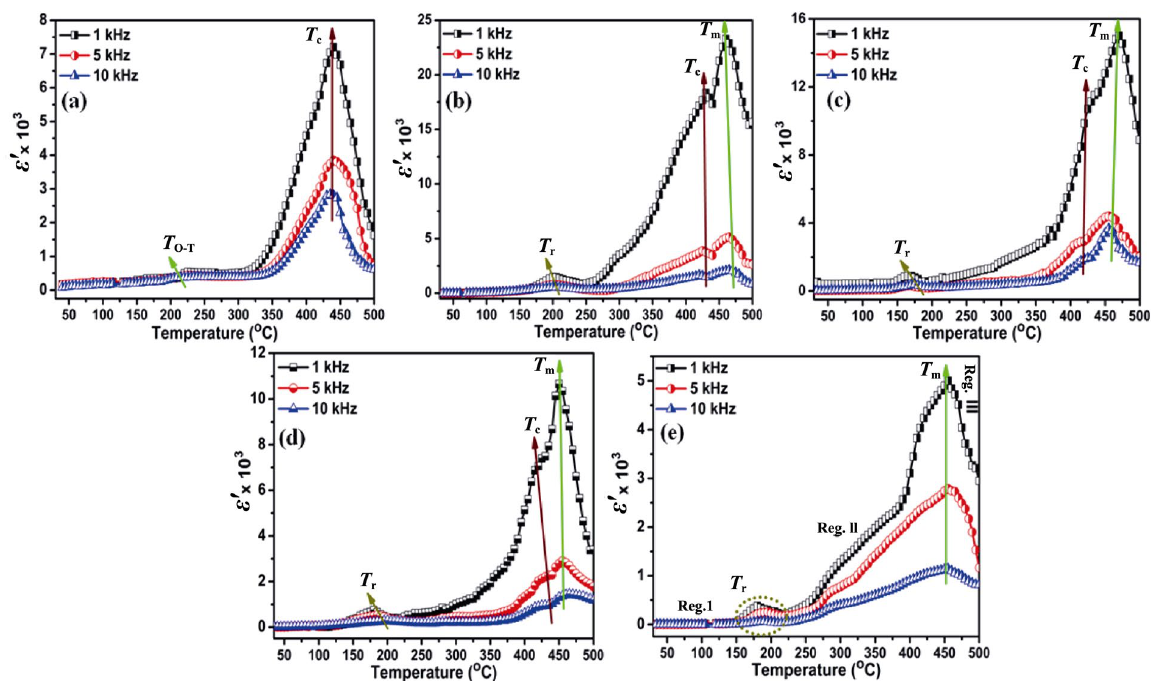
Fig. 4 Temperature dependence of dielectric constant ( ε′ ) for (1 ̶ x )KNN–( x )BHF composites: (a) KNN, (b) x = 30 wt%, (c) x = 40 wt%, (d) x = 50 wt%, and (e) BHF.